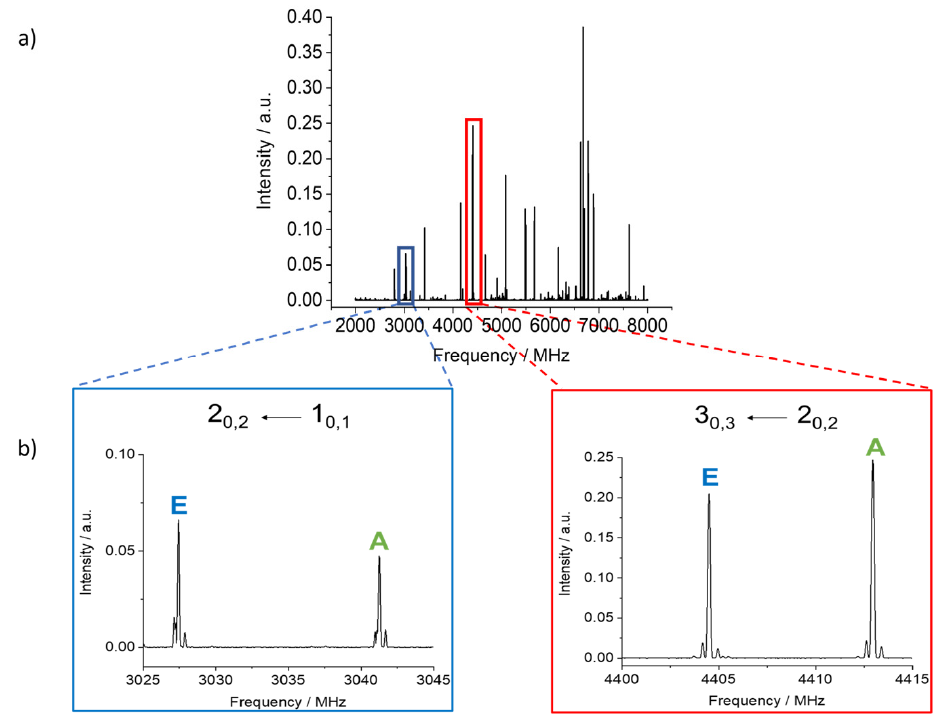
Figure 4. ( a ) The chirped pulse FTMW spectrum of 4MNP-1 recorded from 2 to 8 GHz. ( b ) Sections of the spectrum showing assigned transitions and torsional species.